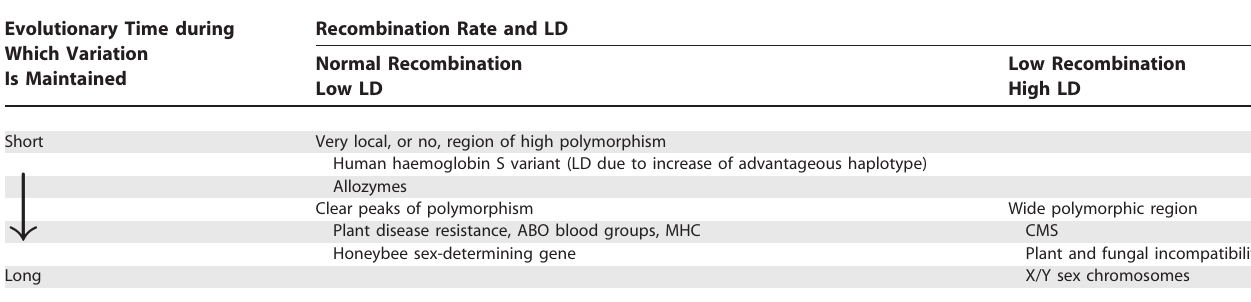
Table 1. Schematic Classification of Balancing Selection, with Some Examples That Are Discussed in the Text Evolutionary Time during Which Variation Is